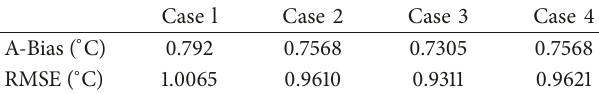
Table 2: Error statistics of the